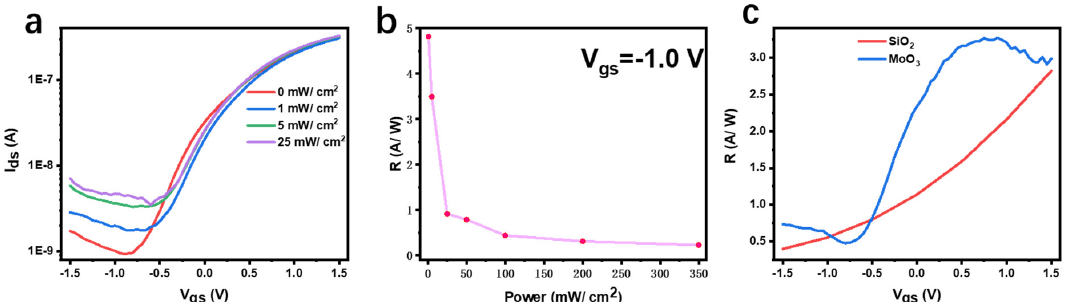
Figure 5. ( a ) Transfer curves of a 405 nm laser with a different light power in MoO 3 medium. ( b ) The relationship between responsivity and optical power at the same gate voltage in MoO 3 medium. ( c ) The relationship between the responsivity and gate voltage of the two media under the same light power (50 mW/cm 2 ).